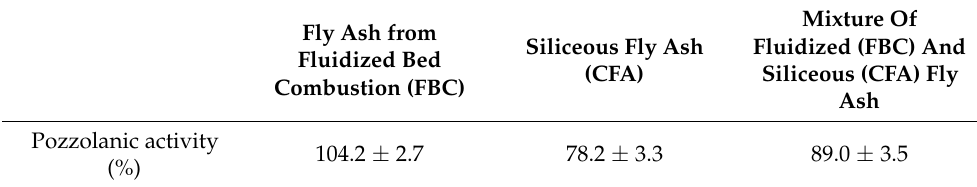
Table 2. Pozzolanic activity of FBC fly ash, siliceous fly ash, and ash mixture according to PN-EN 450-1:2012.